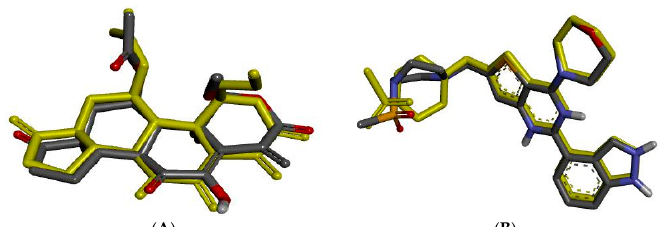
Figure 3. Native ligand (yellow) overlap with its best docked pose (black) in a re-docking protocol. ( A ) Native ligand of PI3K α overlap with its best docked pose; ( B ) Native ligand of PI3K β overlap with its best docked pose. Table 3. The inhibitory e ff ect of compounds 5h and 5m on cell migration.